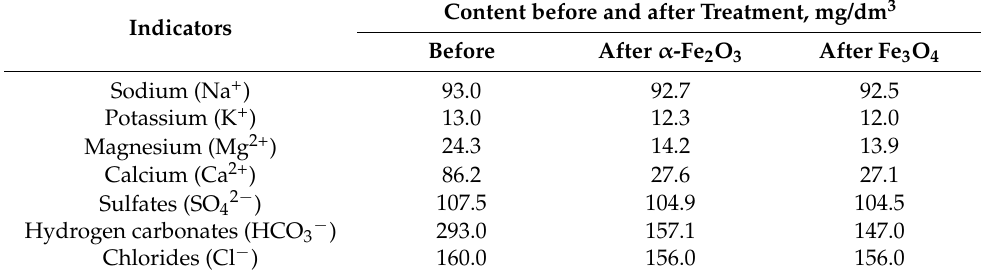
Table 2. Chemical composition of the drinking water before and after its treatment with respective sorbents α -Fe 2 O 3 and Fe 3 O 4